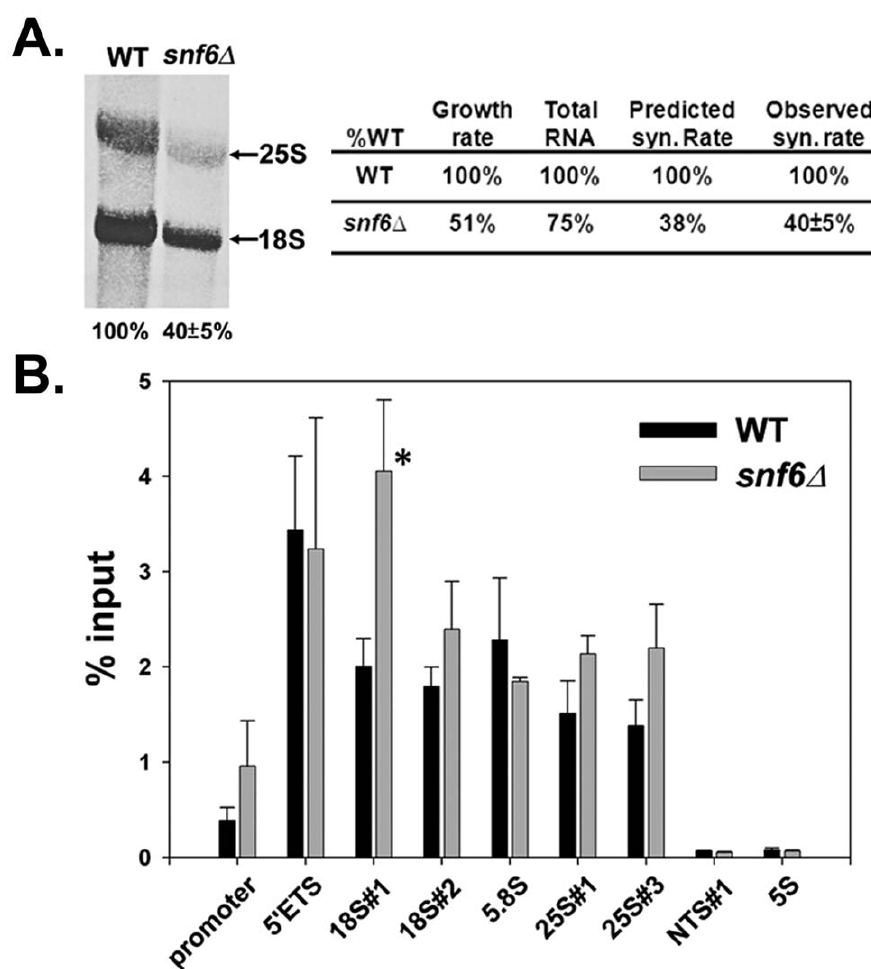
Figure 3. rRNA synthesis rate of snf6 D is only 40% of WT despite similar Pol I occupancy. (A) Yeast cells were cultured in SD-met media to an A 600 , 0.3. Then [methy- 3 H]methionine was incorporated into cells for 5 min followed by a 5 min chase with excess (500 m g/ml) cold methionine. RNA was isolated, run on an agarose gel, transferred to nitrocellulose membrane, and detected by autoradiography. Pol I transcription in snf6 D was normalized to WT. Data were analyzed from 2 independent [methy- 3 H]methionine incorporation assays. Only one dataset is shown here. (B) Pol I occupancy of rDNA in snf6 D resembles that of WT by ChIP except for a 2-fold increase of Pol I occupancy in snf6 D at the 5 9 end of the 18S gene (asterisk). An anti-A190 polyclonal antibody was used to immunoprecipitate Pol I complexes. The 8 primer pairs described for Figure 2 were used in real-time PCR to check the association of Pol I complex with rDNA. A ninth primer pair measured Pol I association with 5S rDNA. Data were quantified from at least 2 10-fold dilutions per sample from duplicate cultures. Error= 6 1standard deviation.